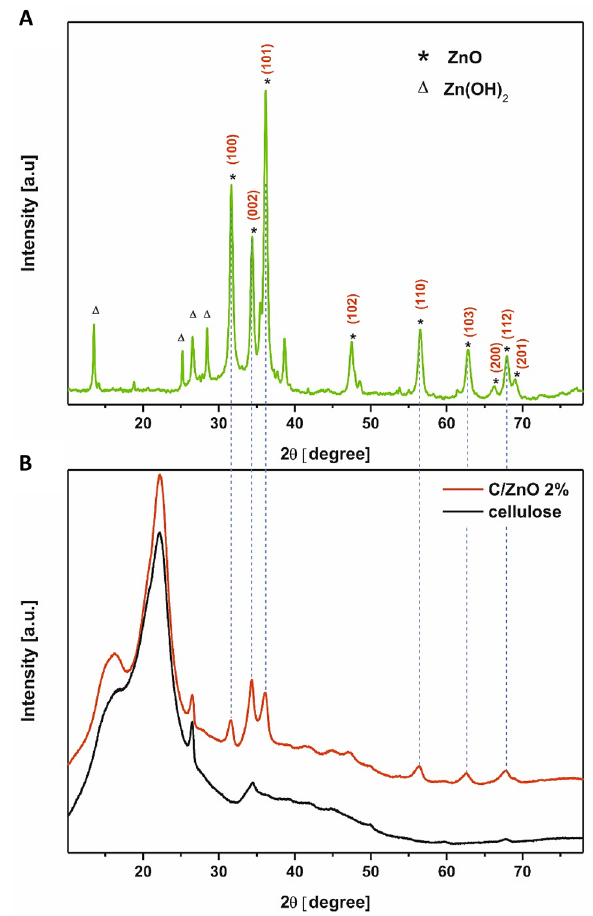
Figure 4. XRD patterns of post-combustion residue of functionalized cellulose fibers ( A ) and pure cellulose fibers (black curve) and cellulose fibers after the functionalization process (red curve) ( B ).